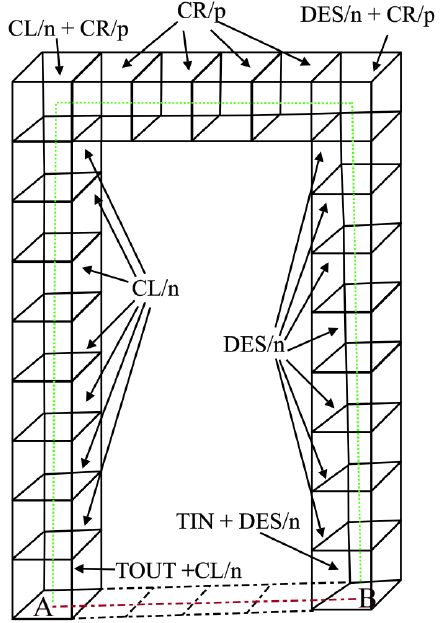
Figure 1. NO x emissions trajectory on the STOCHEM grid. TOUT stands for taxi out, CL for climb, CR for cruise, DES for descent, TIN for taxi in, p for the number of grids that the path from A to B spans and n for the number of levels.